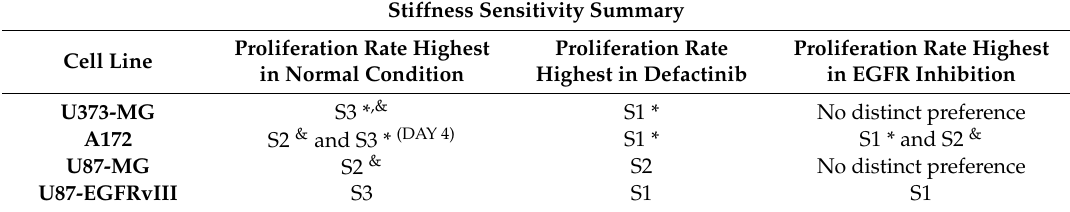
Table 1. Summary of results of elastic modulus versus proliferation assays under no drugs, defactinib, and EGFR inhibition. Statistical significance: * p < 0.05 when S1 and S3 values were compared; & p < 0.05 when values of S2 and S3 were